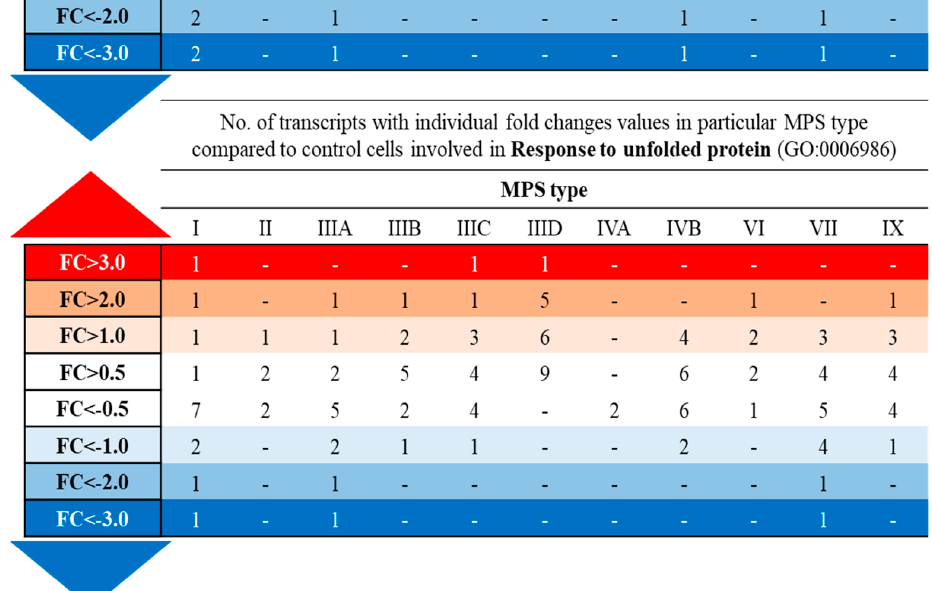
Figure 6. Number of transcripts included into indicated Gene Ontology terms with altered expression ( p < 0.1 in one ‐ way ANOVA and post hoc Student’s t ‐ test with Bonferroni correction) depending on the level of fold ‐ change (FC) value in different types of MPS relative to HDFa control cells.